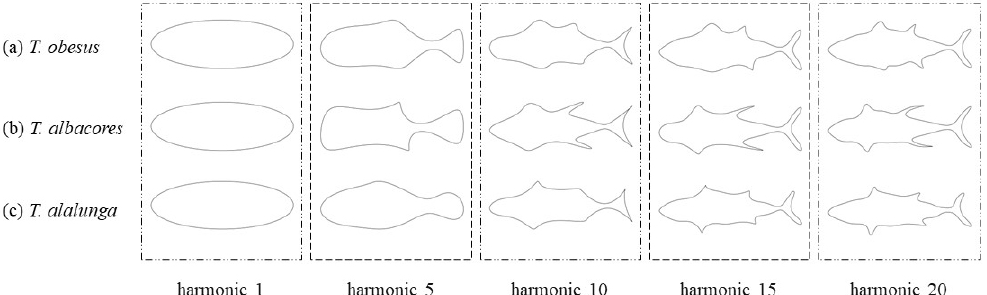
Figure 3. Morphological reconstruction of three Thunnus species from the number of Fourier harmonics.